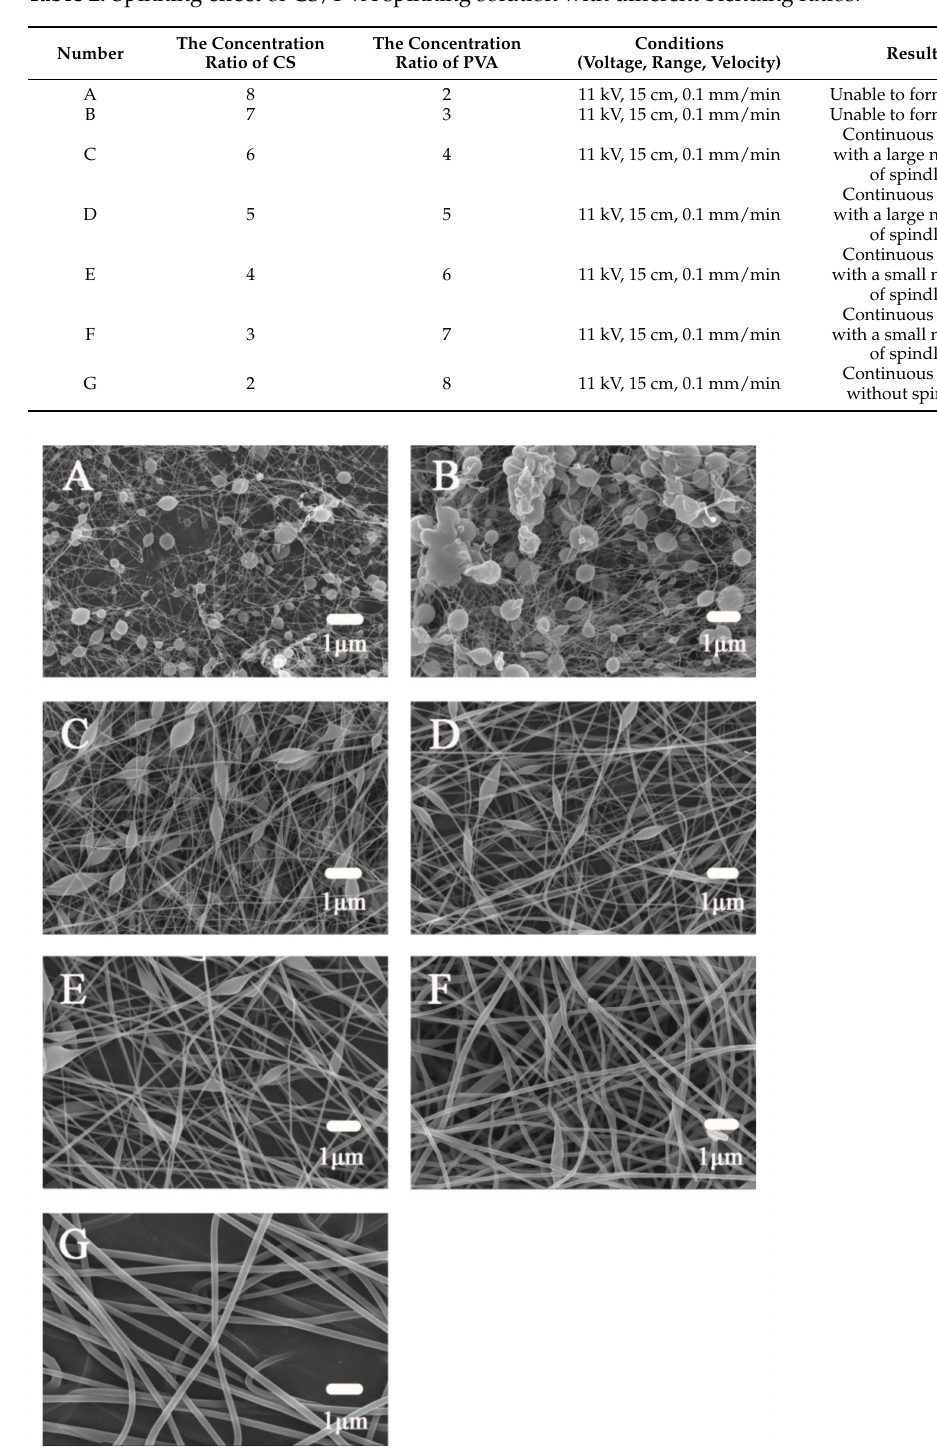
Table 2. Spinning effect of CS/PVA spinning solution with different blending ratios.